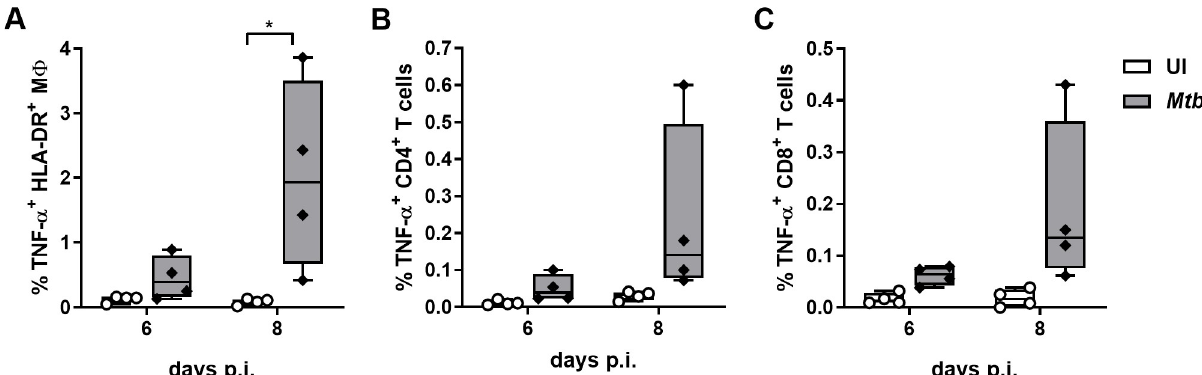
Fig 4. Late TNF- α production by Mtb -induced granulomas originates from T cells as well as macrophages. Frequencies of TNF- α -producing macrophages (A) and CD4 + (B) or CD8 + T cells (C) from uninfected PBMCs (UI) or granulomas 6 and 8 days post-infection with Mtb H37Rv (median with interquartile ranges, minimum and maximum values for 4 independent donors). Statistical analysis was performed using Friedman test; � , p <